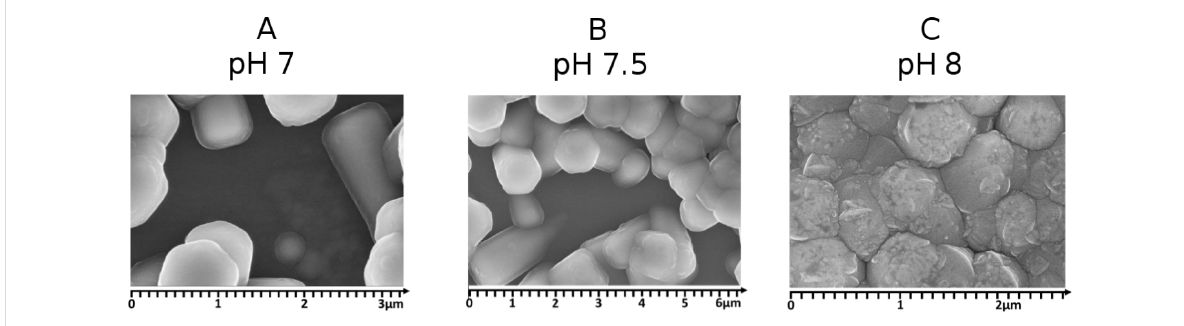
Figure 4: SEM images of the three investigated types of structures with different surface morphologies.